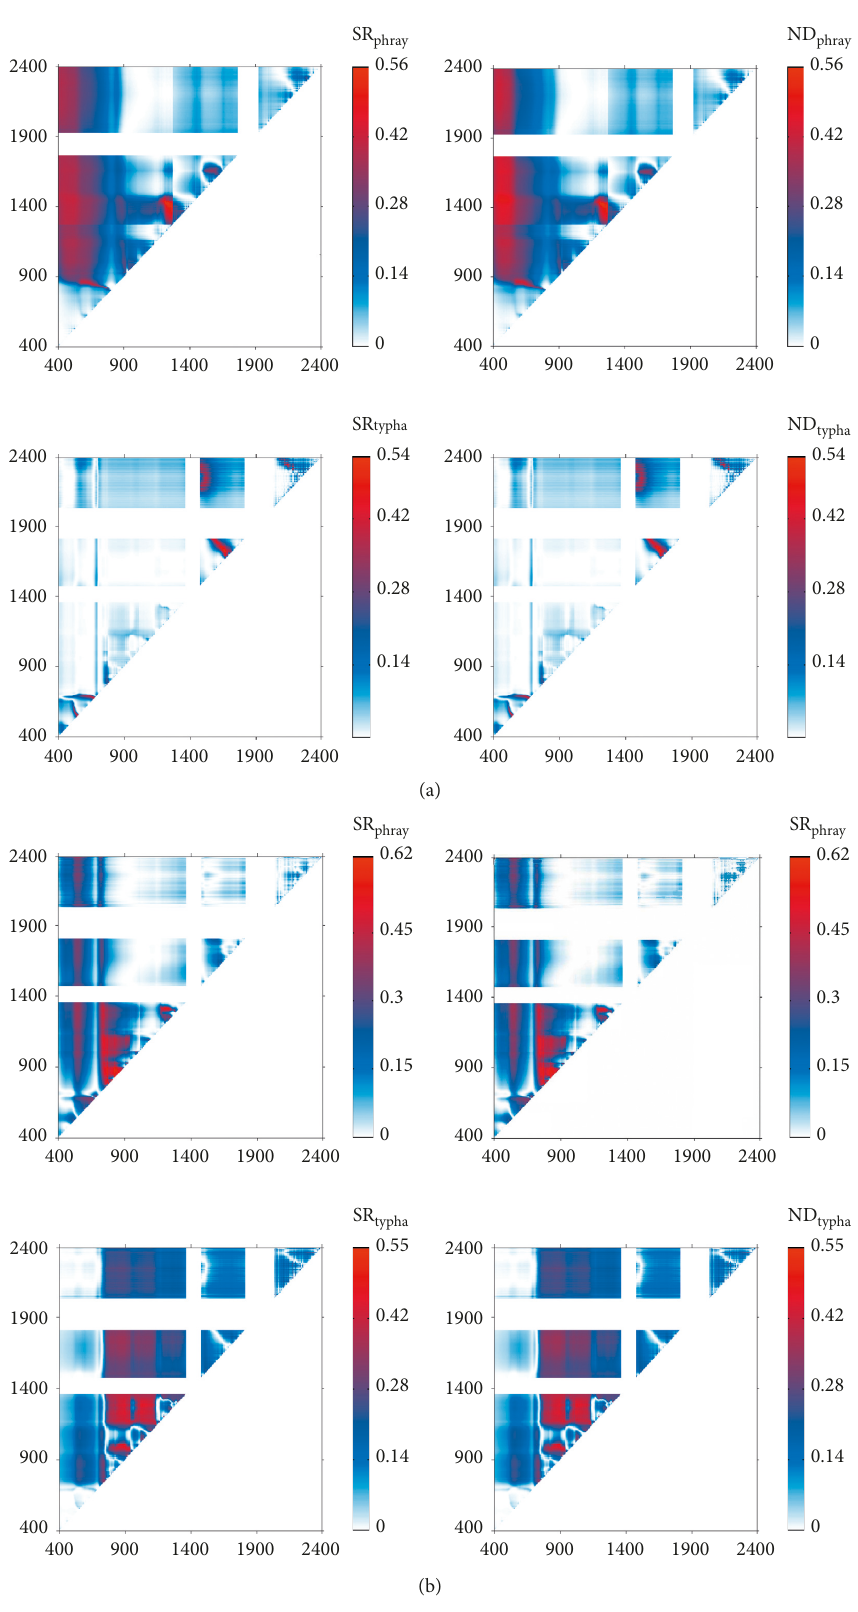
Figure 2: 2-D correlation plots illustrating coefficient of determination between spectral indices and TN contents in water (a) and plants